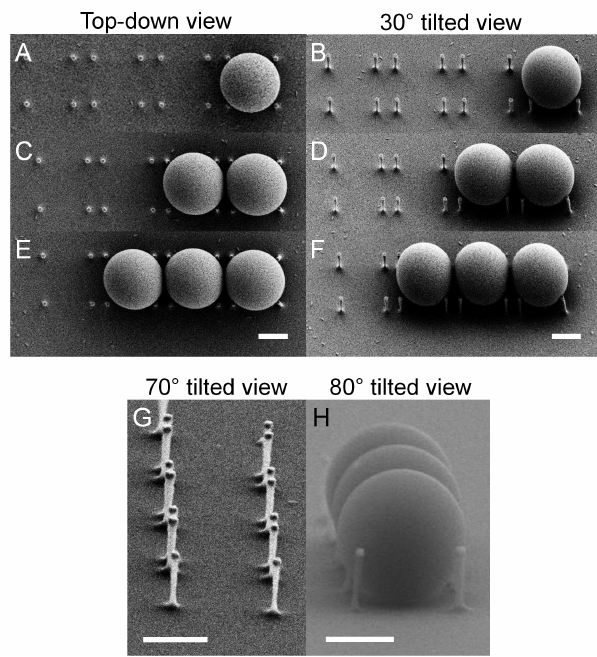
Figure 3: (A), (C), (E) Top and (B), (D), (F) side view (30 ∘ tilt angle) of discrete optoplasmonic structures with 1, 2 or 3 OMs (diameter: 2 µ m). Side views of pillar scaffolds (G) before and (H) after inte- gration of OMs. The Au nanoparticles are clearly discernible at the tip of the pillars. Scale bars are 1 µ m. Reprinted with permission from Ahn et al. ACS Nano 6, 951 (2012). Copyright 2012 American Chemical